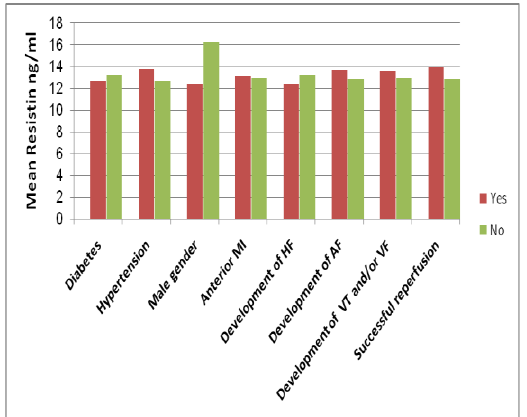
Figure 2: Association of admission resistin level to selected clinical variables among patients with